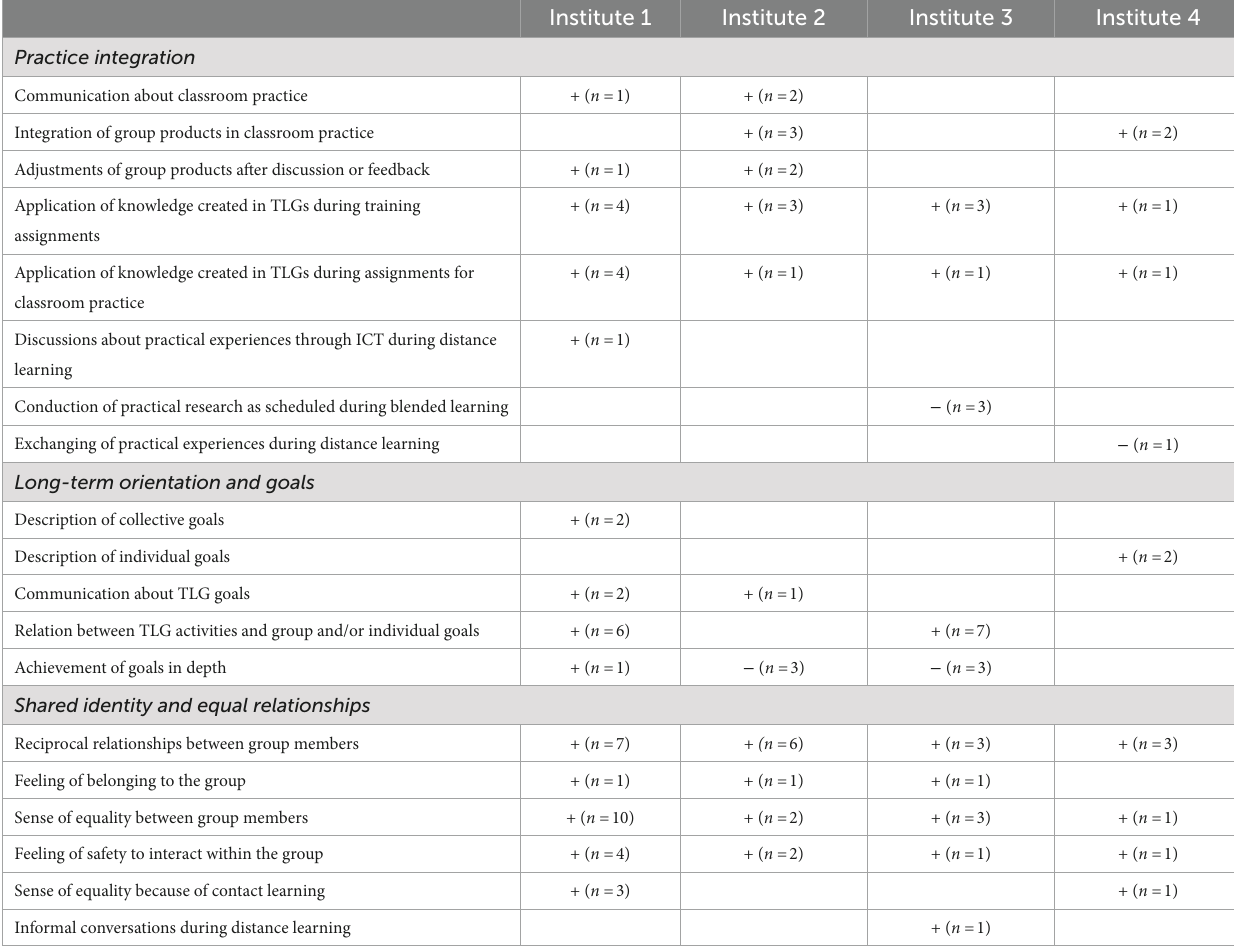
TABLE 5 Social configurations at the four different